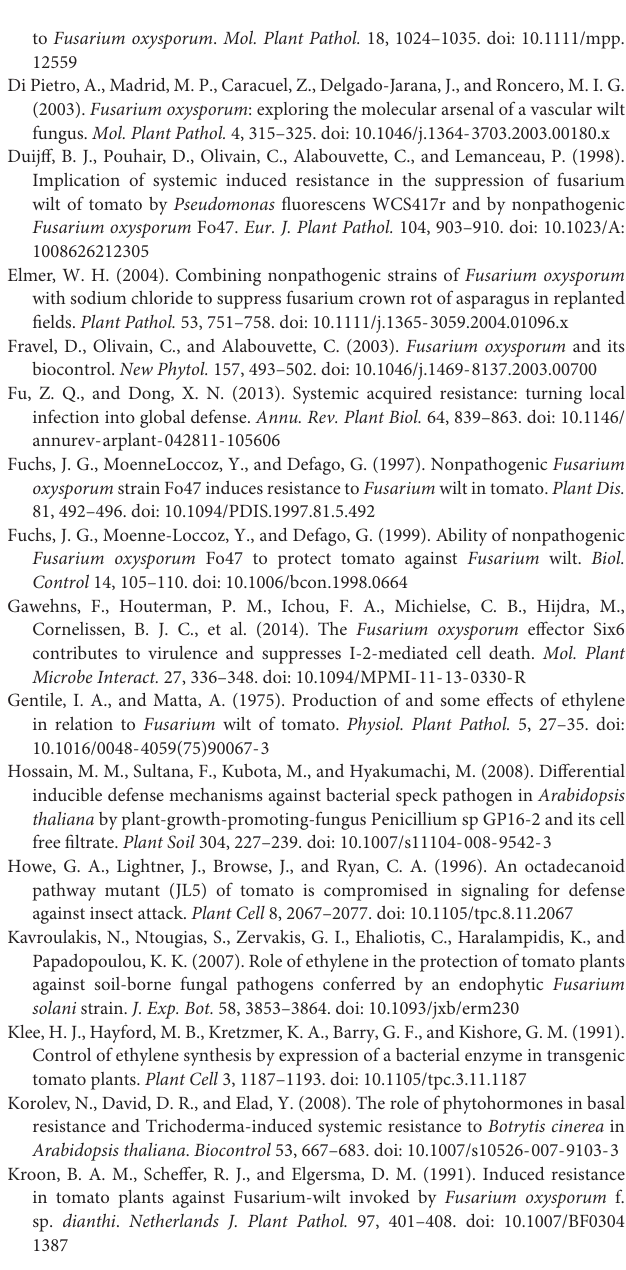
FIGURE S1 | Expression of SA, JA or ET marker genes is unaffected by EMR. (A) Ten days old wild-type tomato seedlings (C32) inoculated with water (mock), Fo47, Fol4287 or co-inoculated with Fo47 and Fol4287. (B) Disease development as assessed by measuring fresh weight and disease index 3 weeks after inoculation. Raw data was analyzed by a non-parametric Mann–Whitney U -test (ns P > 0.05, ∗ P < 0.05). (C) Expression levels of the SA biosynthesis genes isochorismate synthase ( ICS ) and phenylalanine ammonia-lyase ( PAL ) or the pathogenesis-related 1a ( PR1a ) SA maker gene in Fo47, Fol4287 or in co-inoculated plants. (D) Expression levels of the JA reporter gene proteinase inhibitor ( PI-I ) in Fo47, Fol4287 or in co-inoculated plants. (E) Expression levels of the ET-regulated marker genes ethylene responsive factor ( Pti4 ) and ethylene receptor ( ETR4 ) in Fo47, Fol4287 or in co-inoculated plants. Gene expression levels were measured using RT-qPCR and depicted relative to that of tubulin . Five biological replicates per each treatment were analyzed. The